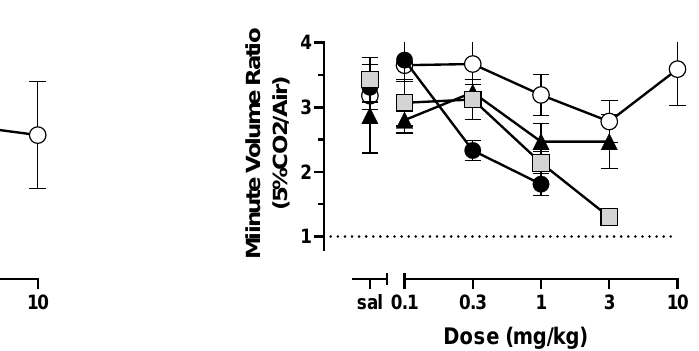
Figure 5. Effects of compounds 8 , 9 , and 17 (in comparison to morphine and saline) on tail withdrawal latency ( left panel ) and on ventilatory ratio ( right panel ) in squirrel monkeys. Compound 8 like morphine, significantly increased tail withdrawal latency and reduced the ability of 5% CO 2 to stimulate increases in ventilation. Compound 17 increased tail withdrawal latency. without significantly altering ventilation, and Compound 9 had inconsistent effect of tail withdrawal latency and did not alter ventilation. Data are expressed as mean ± SEM ( n = 3 – 5; results of statistical analysis are presented in text).